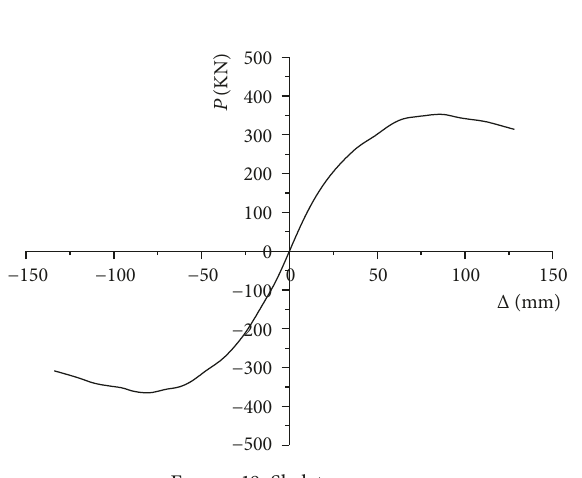
Figure 18: Skeleton curve.